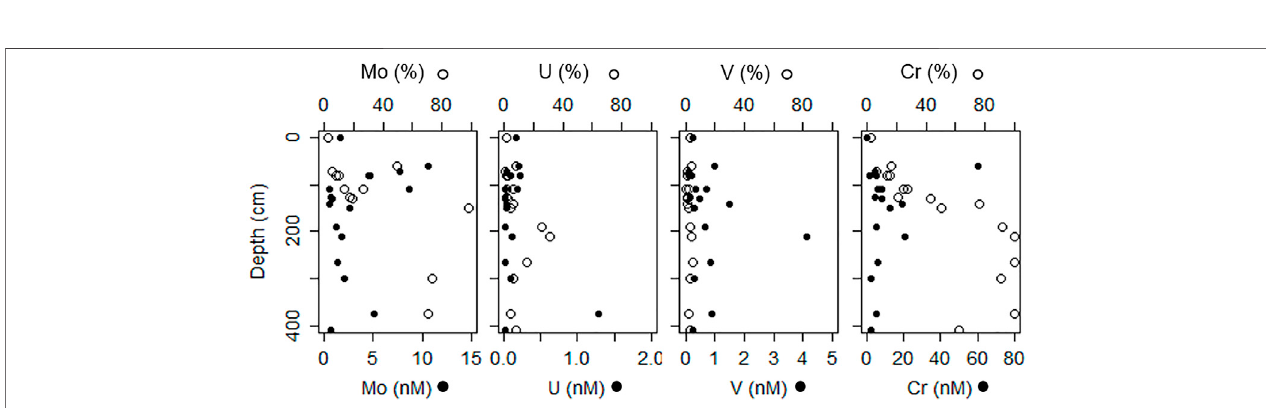
FIGURE 3 | Groundwater depth pro fi les for concentrations (solid circles; lower axis) and percent of total dissolved metal (open circles; upper axis) associated with hydrophobic organic matter (as determined by extraction on a C18 column). Surface water concentrations are shown at 0 cm depth.